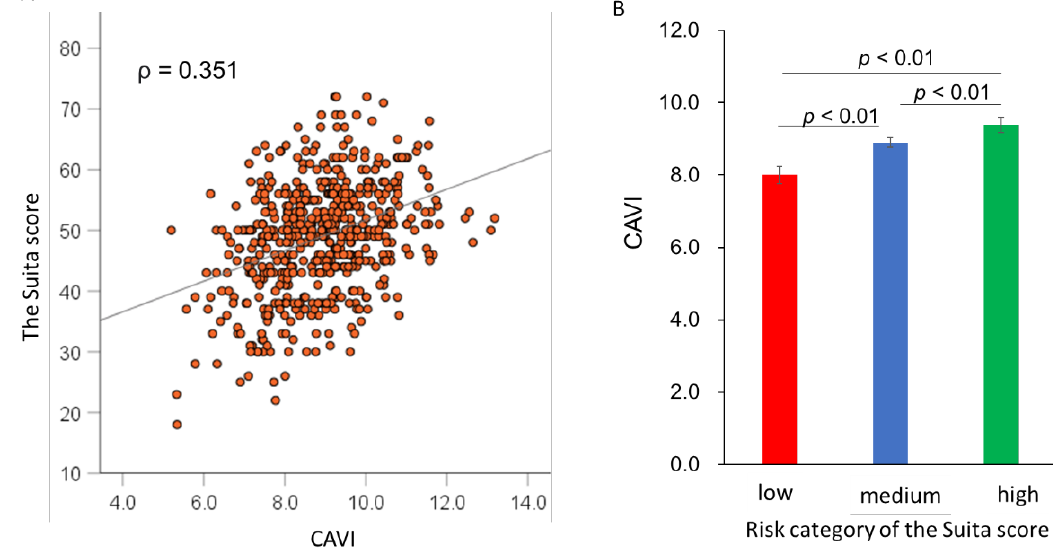
Figure 2. Correlation between CAVI and the Suita score. Scatter plot showing the correlation between CAVI and the Suita score ( A ) and CAVI according to the risk category of the Suita score ( B ) .